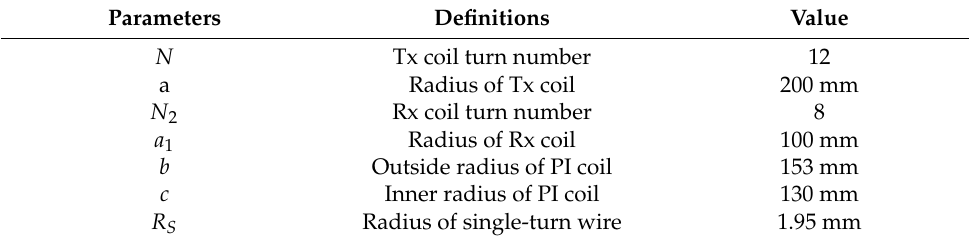
Table 2. The parameters of magnetic coupling